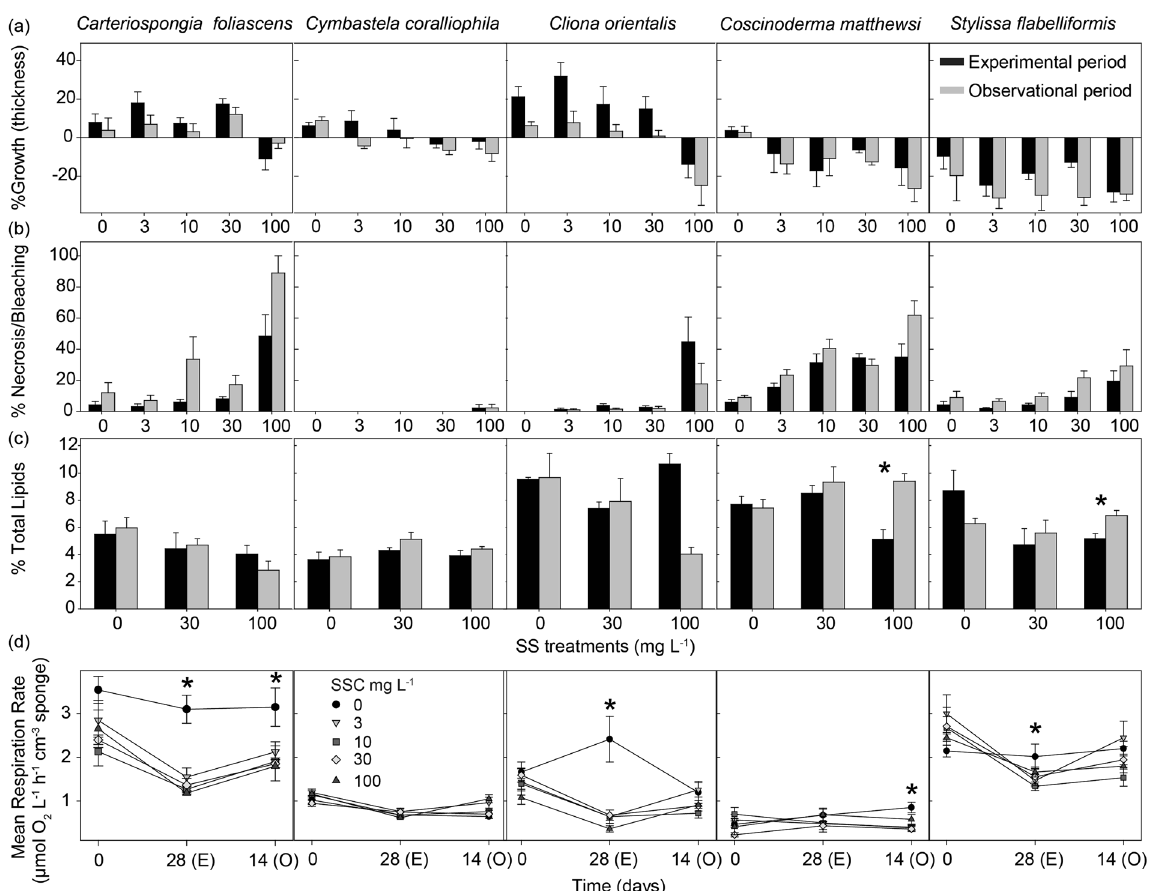
Figure 2. Physiological responses of sponges to elevated SSCs. ( a ) Percentage of growth (mean ± SE) (based on sponge tissue thickness), ( b ) Percentage of necrotic or bleached tissue, ( c ) Percentage of sponge biomass comprised of lipids, and ( d ) Mean respiration rates ( µ mol O 2 L − 1 h − 1 cm − 3 sponge), for all species and SSCs (0, 3, 10, 30 and 100 mg L − 1 ) after the 28 d experimental period ( E ), and 14 d observational period (O) (mean ± SE). Asterisks show statistically significant differences between the experimental and observational phase in a–c and between treatments in d (t-tests: P <